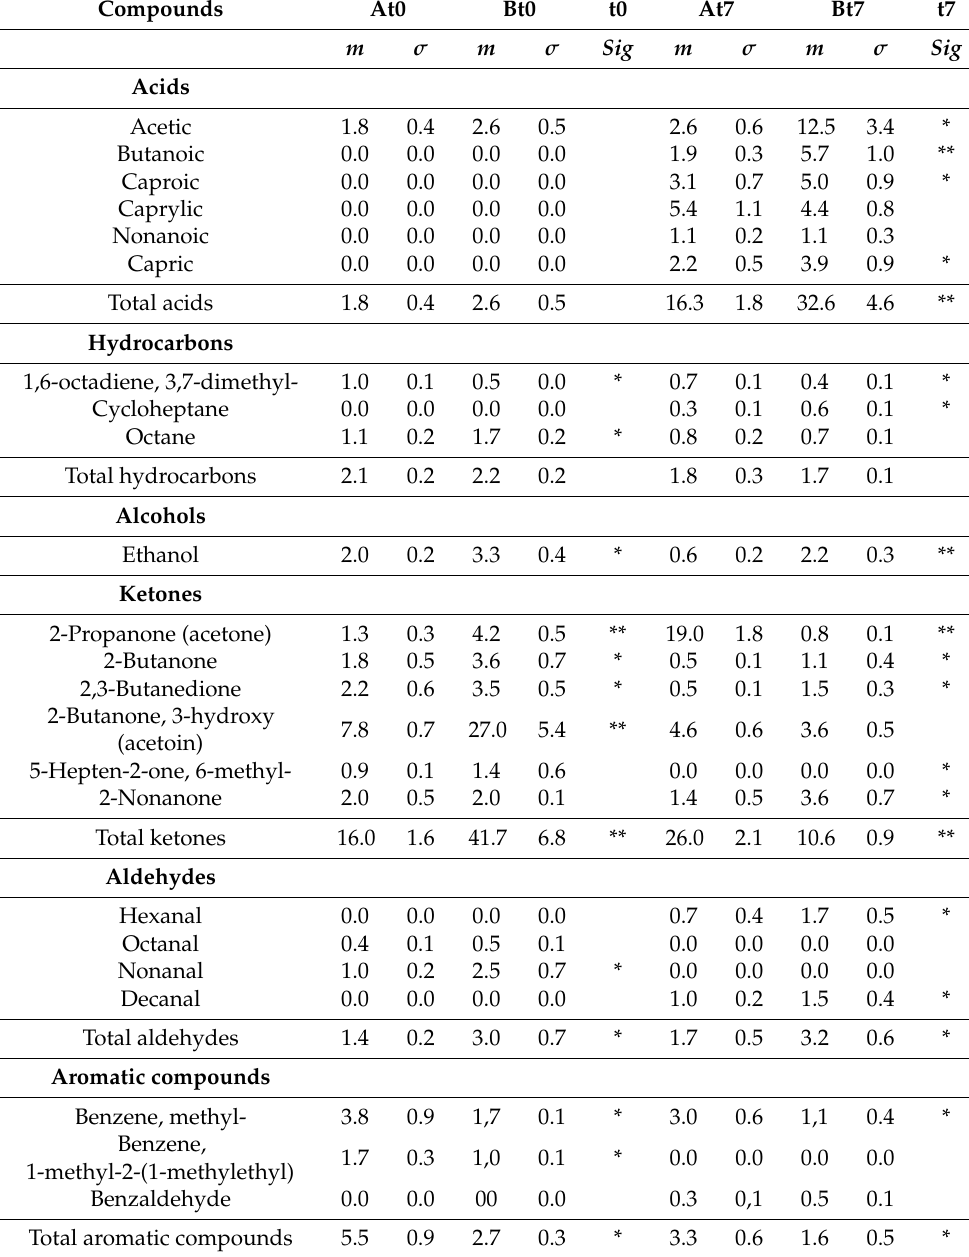
Table 5. Volatile organic compounds of the cheese samples from trials A and B at 0 and 7 days of refrigerated storage (expressed as % of total peak area). X = mean; σ = standard deviation; * = different in A and B at p < 0.05; ** = different in A and B at p < 0.01.